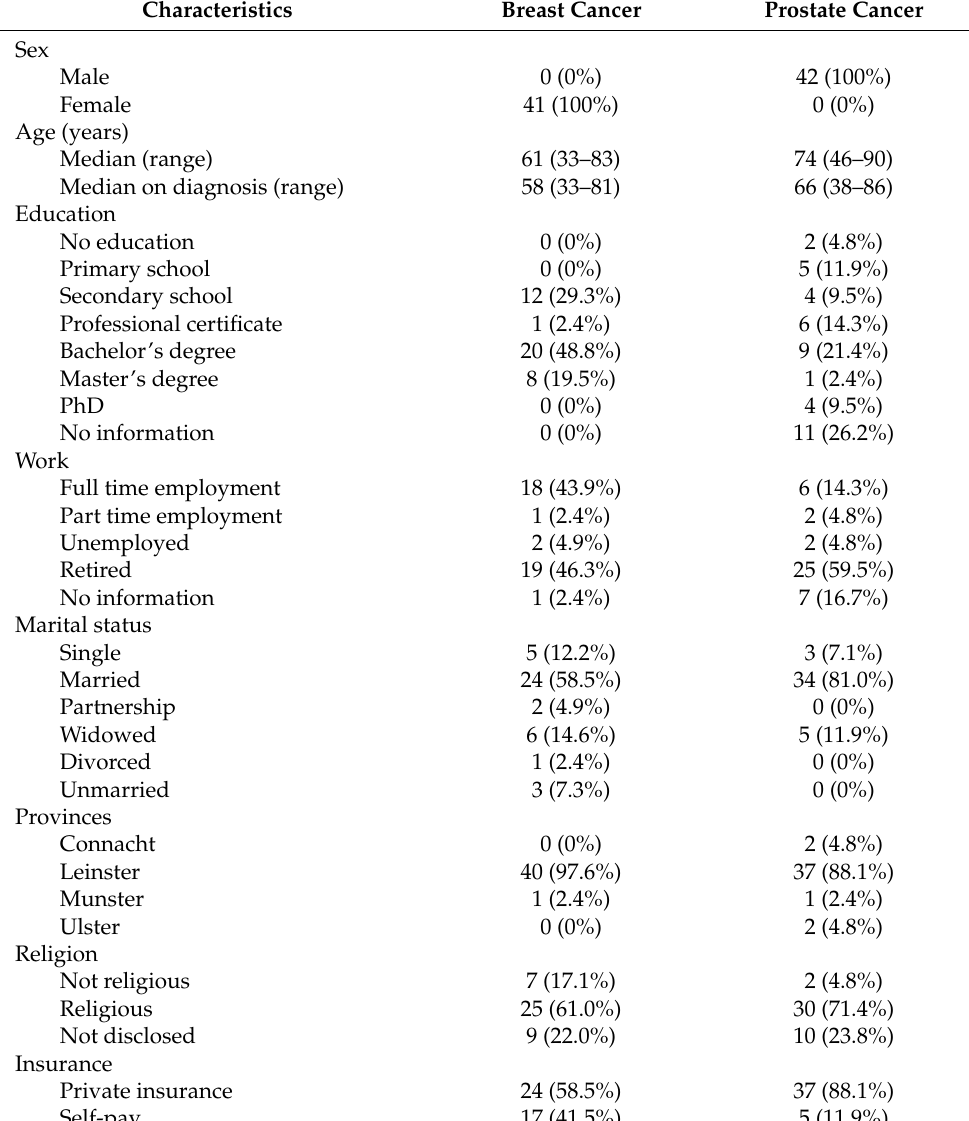
Table 1. Participant